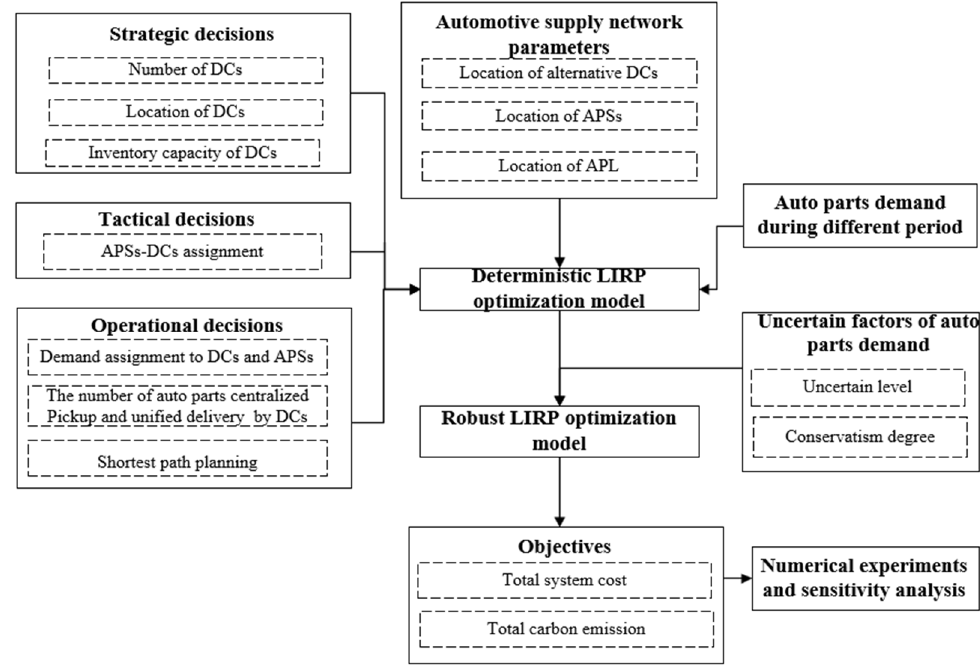
Figure 1. The research framework for auto parts supply logistics.